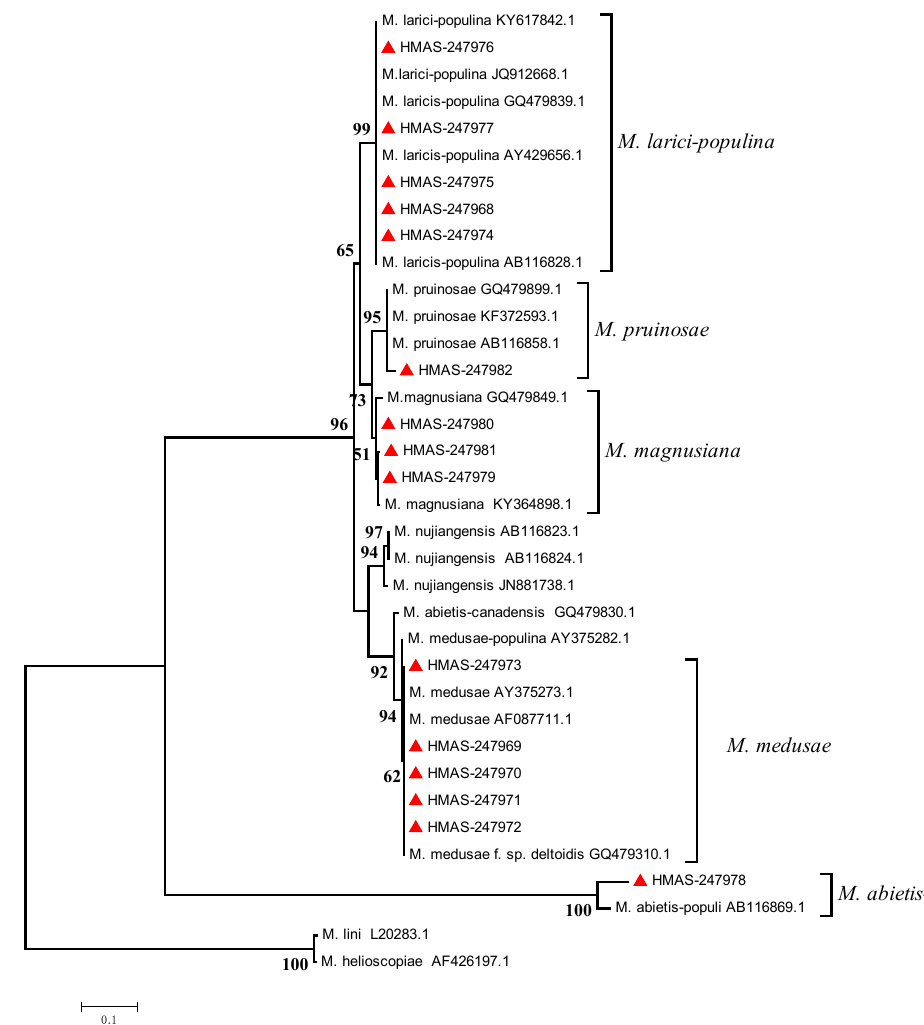
Figure 4. Maximum Likelihood (ML) phylogenetic tree of nrDNA-ITS sequences of species of Melampsora from HMAS collections (red triangles) made during poplar leaf rust surveys in China, 2015–2018. Bootstrap values >50% are shown.